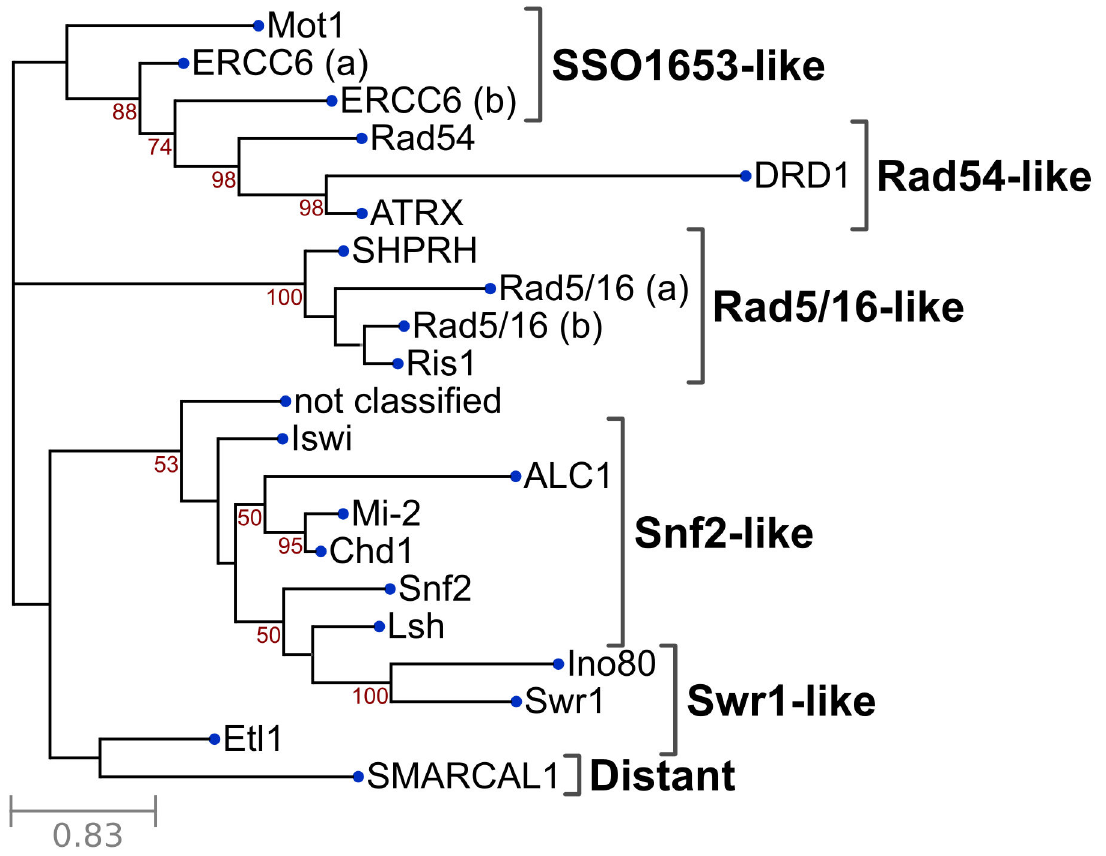
Figure 2. Unrooted phylogenetic tree of all candidate Snf2 genes in plant genomes. The full tree from which this subset was extracted is presented in Figure S3. The subfamily branches were collapsed to a single node that represents the first split that is part of the subfamily branch. Confidence values (50-100) are indicated at the relevant splits of the branches. The tree is based on 100 bootstrap replicates. The leaf tagged ‘not classified’ indicates candidate Snf2 members that are not part of a known subfamily, including Cre09.g390000.t1.1 ( Chlamydomonas reinhardtii ) and members of sequence databases. doi: